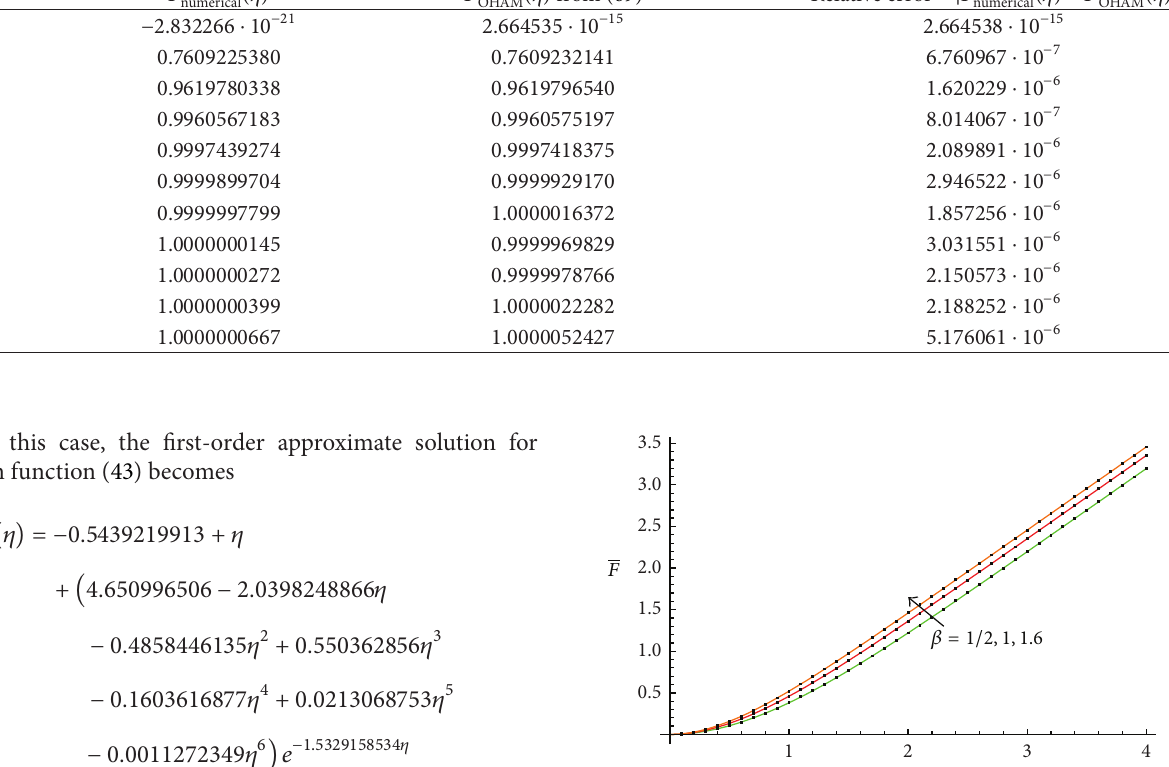
Figure1:Comparisonbetweentheapproximatesolutions(49),(57), and (65) and numerical results with the auxiliary function equation (34) in the cases 𝛽 = 1/2 , 1, and 1.6, respectively: —numerical; ... OHAM